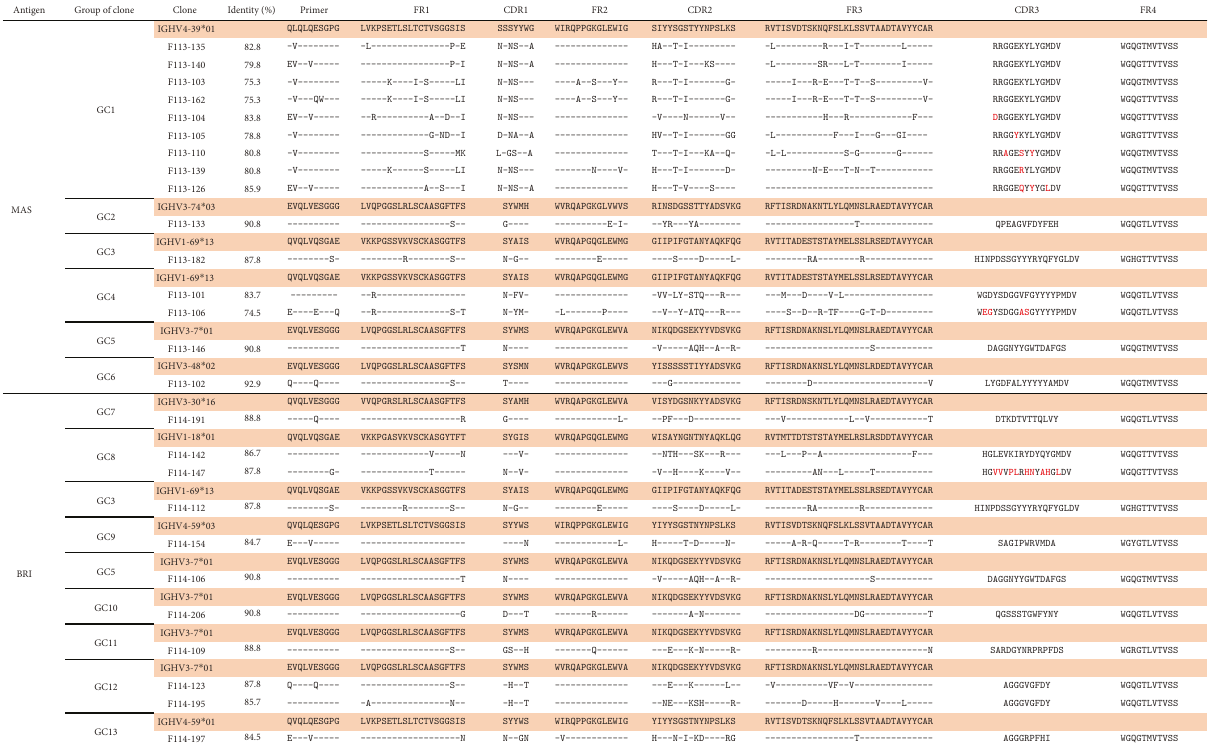
Figure 1: Amino acid sequences of the V region of the 26 Abs isolated in this study. Germline V H assigned and their amino acid sequences are shown. Dash indicates the same amino acid as that of the germline gene. Amino acids that di ff er from that of the germline gene are given. Identity (%) indicates the degree of similarity between the germline gene and that of the respective Ab.